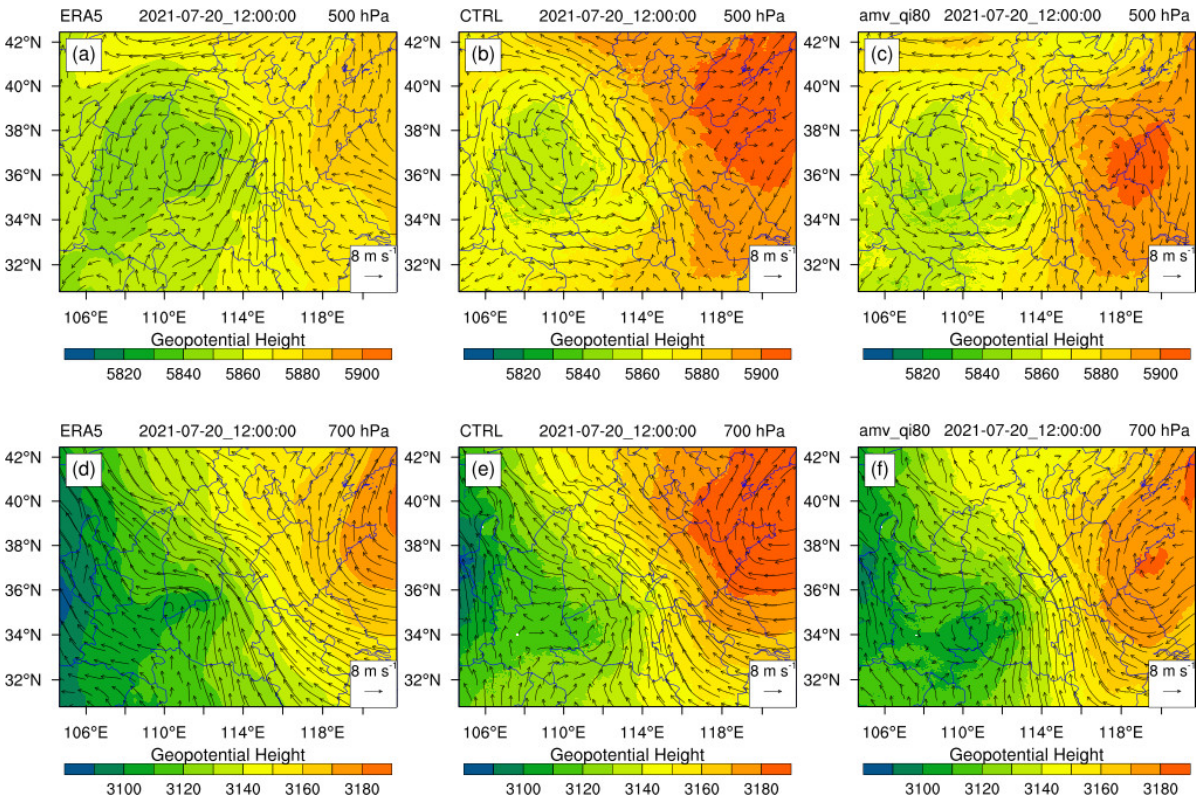
Figure 14. Wind fields and geopotential heights from ERA5 reanalysis data, the CTRL and the amv_qi80 for ( a–c ) 500 hPa and ( d–f ) 700 hPa over the 3 km domain, initialized at 00 UTC 20 July 2021.